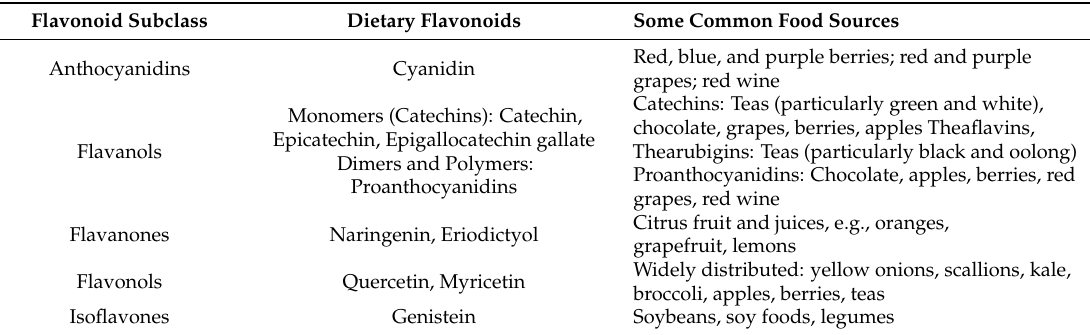
Table 1. Major flavonoids cited in this